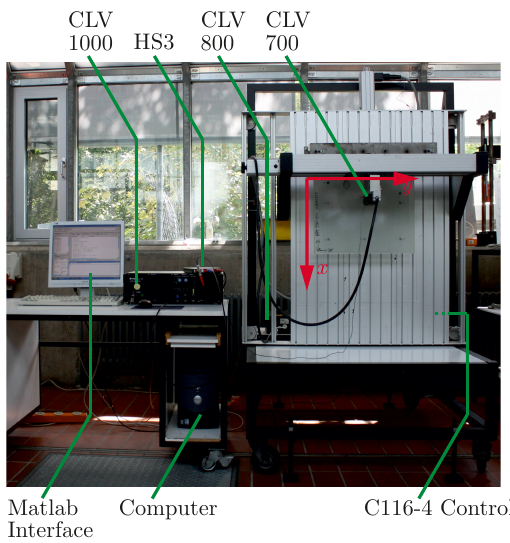
Figure 11. Experimental setup of the 1D LDV mounted on an x - y